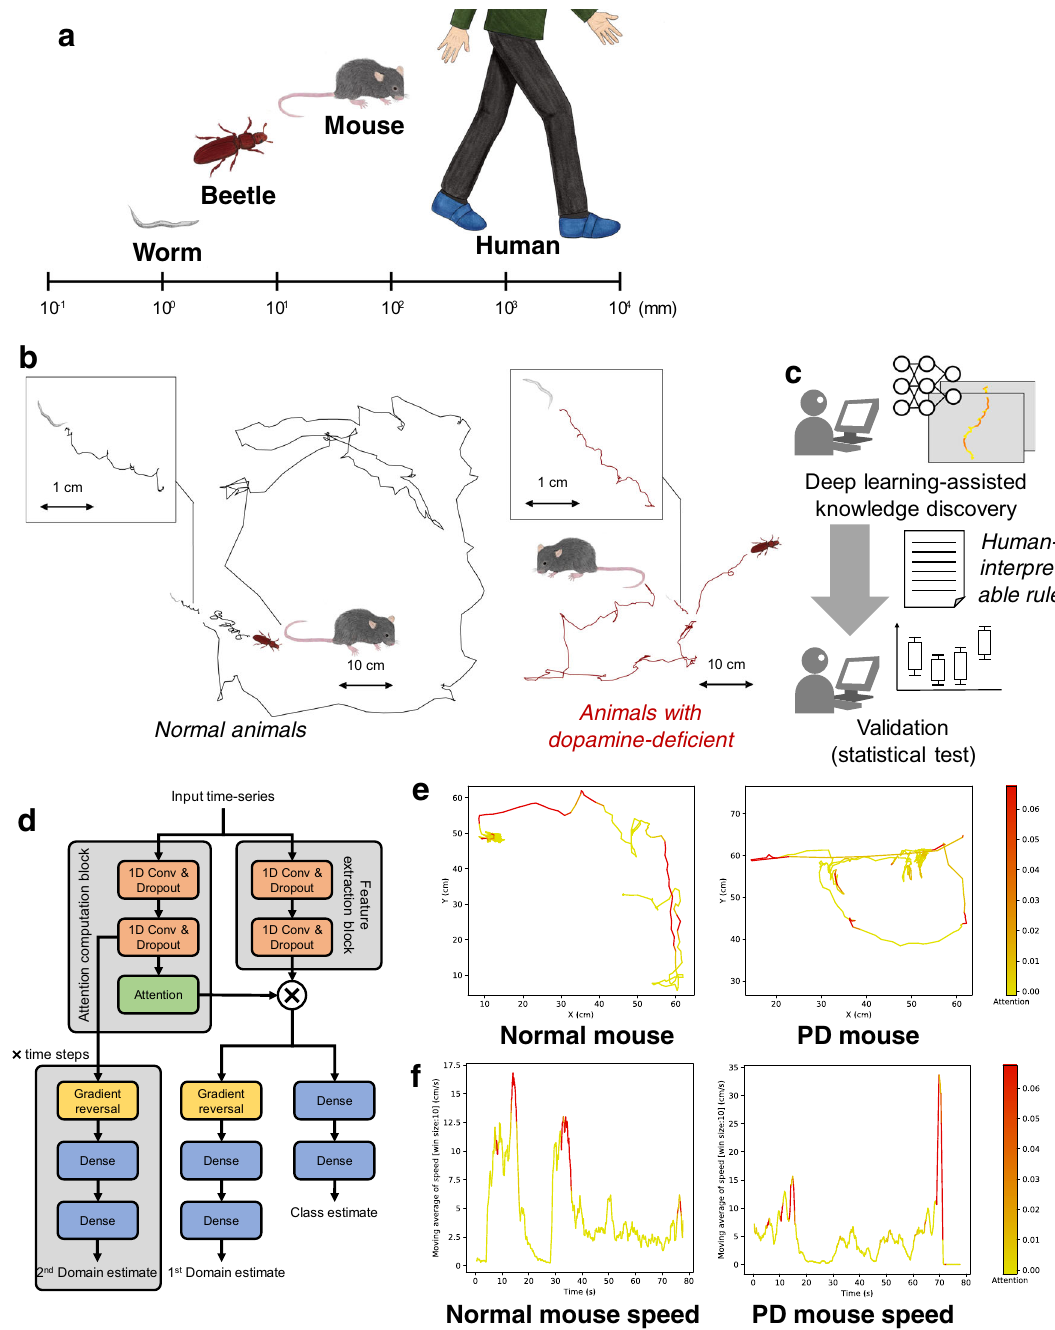
Fig. 1 Cross-species behavior analysis using a domain-adversarial neural network with attention mechanism. a Differences in body scales among different species. b Locomotion trajectories of different animals (worm, beetle, and mouse) differ at the spatial scale, but show similar patterns, left, black lines depict locomotion trajectories of normal animals, right, red lines show trajectories of dopamine-de fi cient individuals, inset, expanded trajectories of worms. c Our proposed procedure automatically fi nds a locomotion feature shared by different animals using deep learning, and exhibits the learned locomotion features, enabling the human operator to extract a hypothesis and validate the statistical signi fi cance. d Proposed network architecture: the feature extraction block learns feature representation that maximizes class prediction accuracy but minimizes domain prediction accuracy by using a gradient reversal layer; the learned feature is assumed to be domain-independent because the feature is incapable of distinguishing between the domains, while the attention computation block computes an attention value for each time slice in a domain-independent manner by using a gradient reversal layer. e Highlighted trajectories of normal and Parkinson ’ s disease (PD) mice by attention values of the neural network that is trained to extract cross-species locomotion features of worms and mice. f Example time-series of the speed of normal/PD mice highlighted by our network, where the attention level is color-coded according to the scale bar shown on the